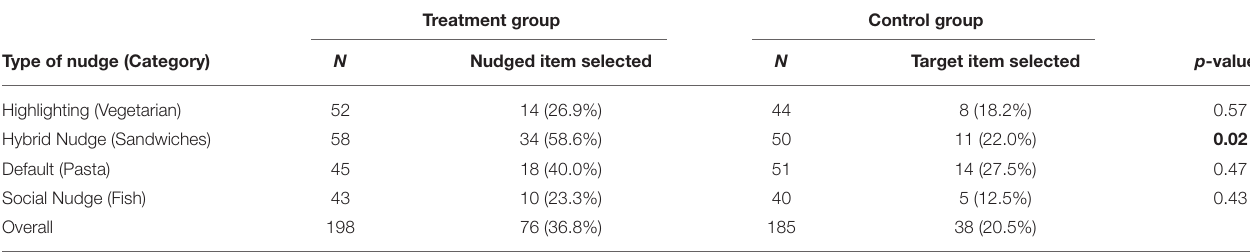
TABLE 2 | Effectiveness of all nudges in Study-1 except for the warning nudge. Treatment group Control